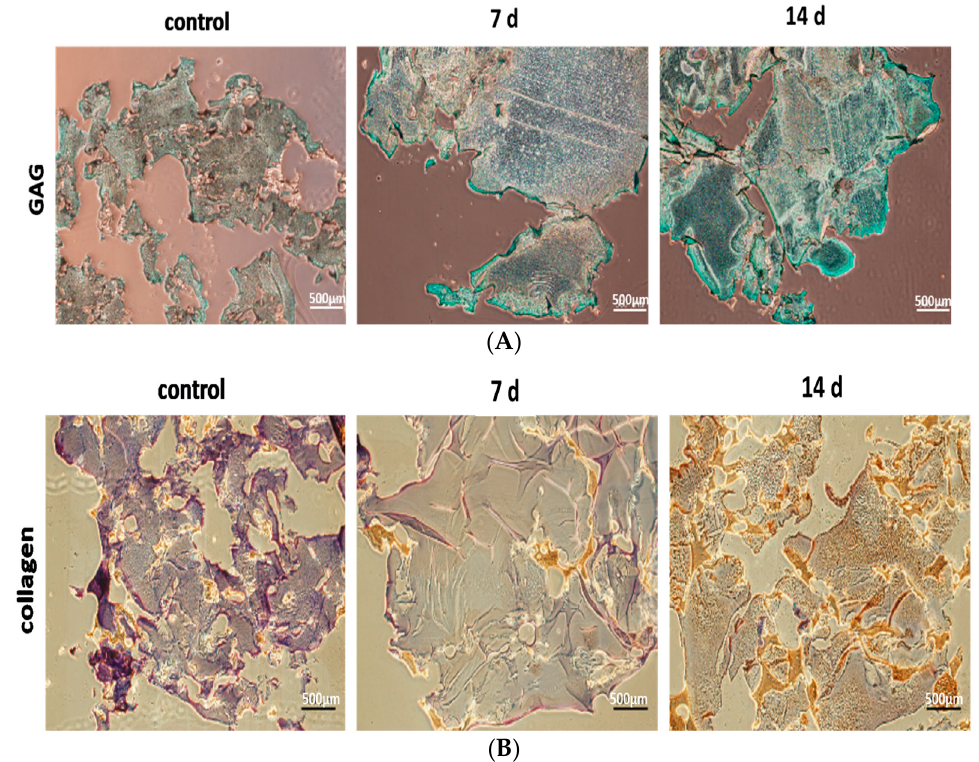
Figure 6. Immuno-histochemical (IHC) analysis of hBMSCs in the model hydrogels after hBMSC were induced by TGF- β 3 to differentiate them to NP cells for 7 d and 14 d, respectively. Deposition of ( A ) GAG (in blue) and, ( B ) Collagen type II (in brown) in the model hydrogels were shown which were significantly higher than those of cultivated in cultural wells (e.g., control group).